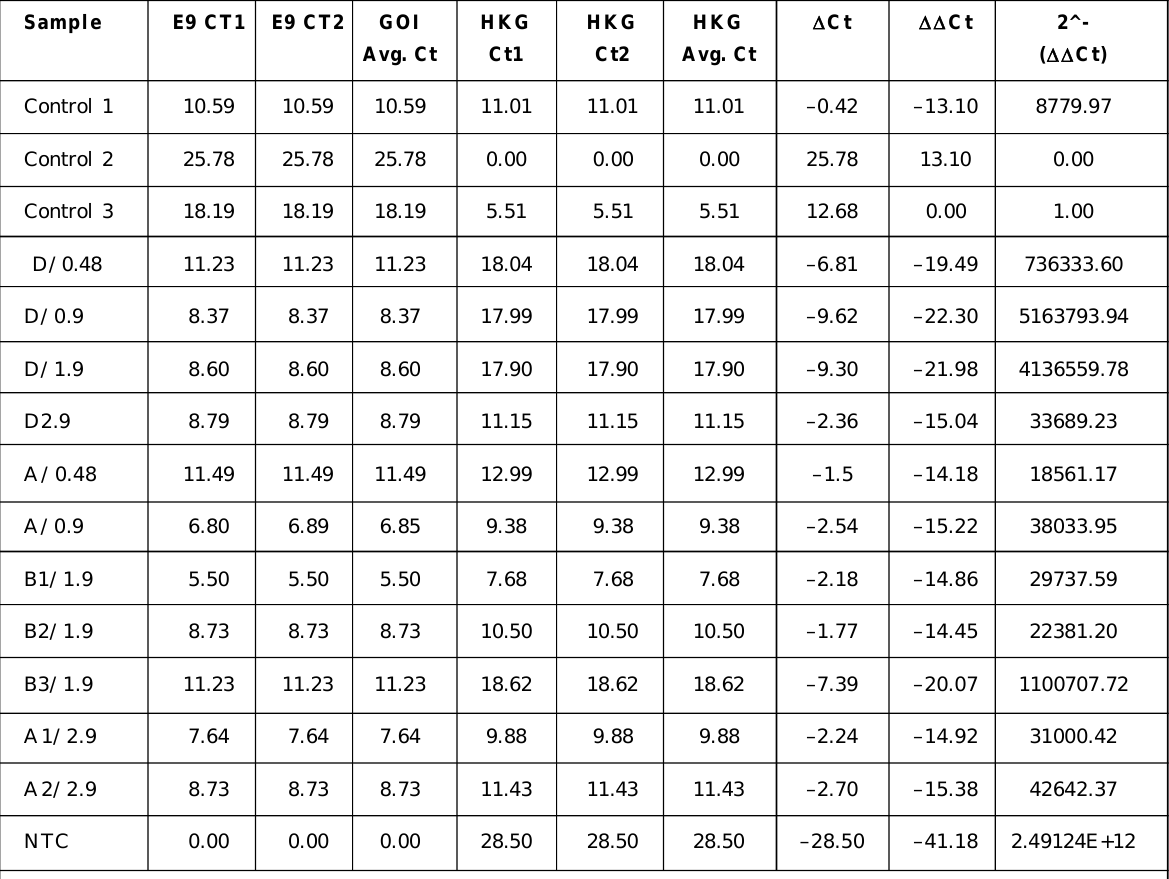
Table 3: Calculated 2 –  CT for LmcesE9 primers with respect to the gene of interest and housekeeping gene (B-actin1)